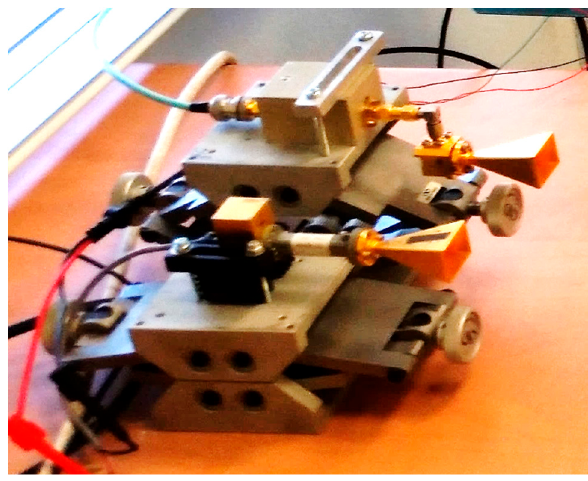
Figure 4. Multi-ray experiment setup. The transmitter and the receiver adjacent to each other.